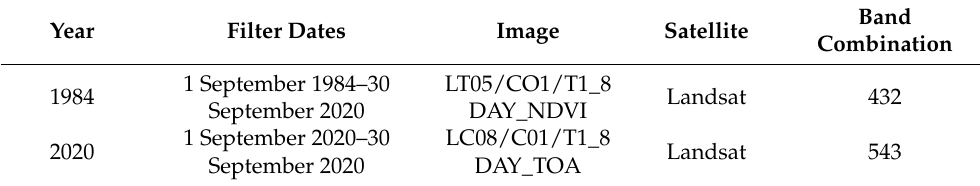
Table A1. Specification of satellite data used for the Chikanta